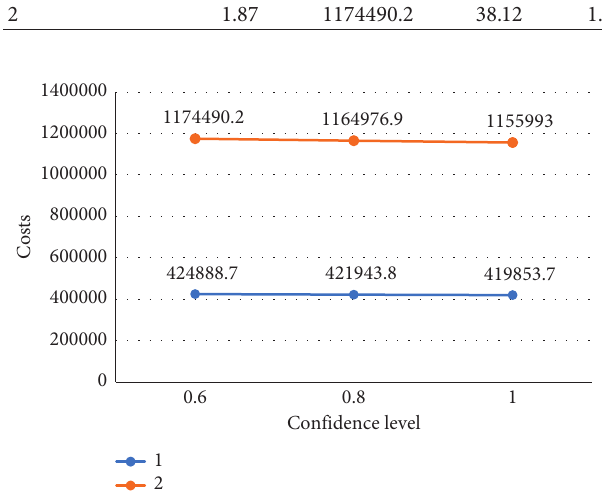
Figure 5: The value of the cost objective function for different confidence